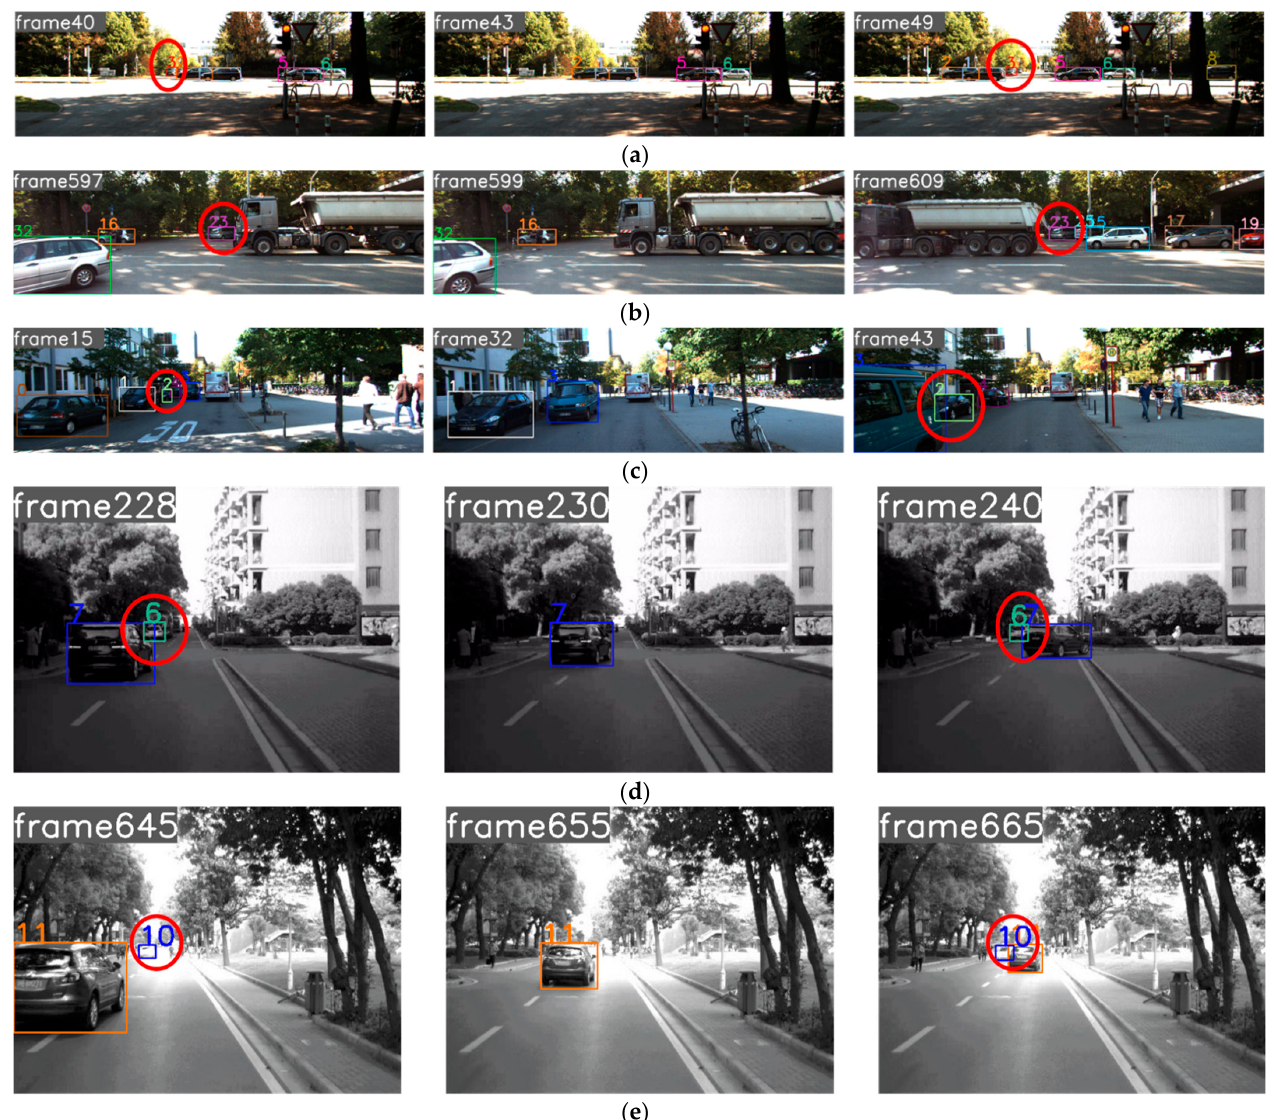
Figure 7. Visual results of some typical scenarios. In each sequence, the tracked vehicle is masked with a unique color and assigned with an ID. The red circles mark the objects severely or long-term occluded in subsequent frames. ( a ) Visual results on the KITTI MOT testing sequence 0017. ( b ) Visual results on the KITTI MOT testing sequence 0015. ( c ) Visual results on the KITTI MOT testing sequence 0018. ( d ) Visual results on the campus scenarios sequence 0002. ( e ) Visual results on the campus scenario sequence 0005.